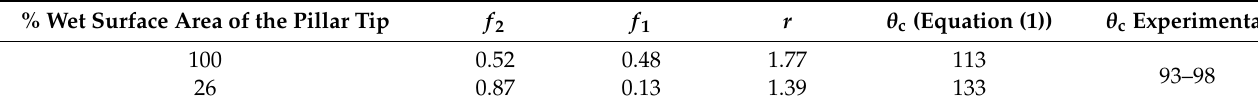
Table 3. Calculation of θ c for an idealized